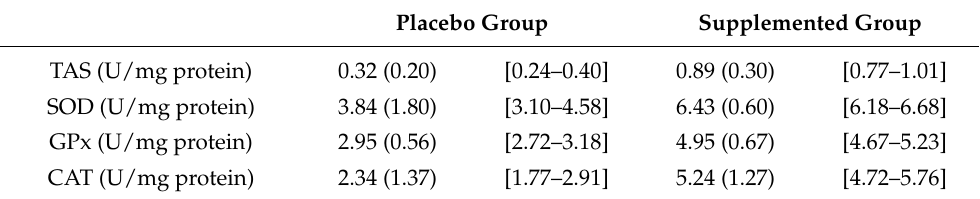
Table 2. Monitoring the oxidative state of participants. Values are expressed as